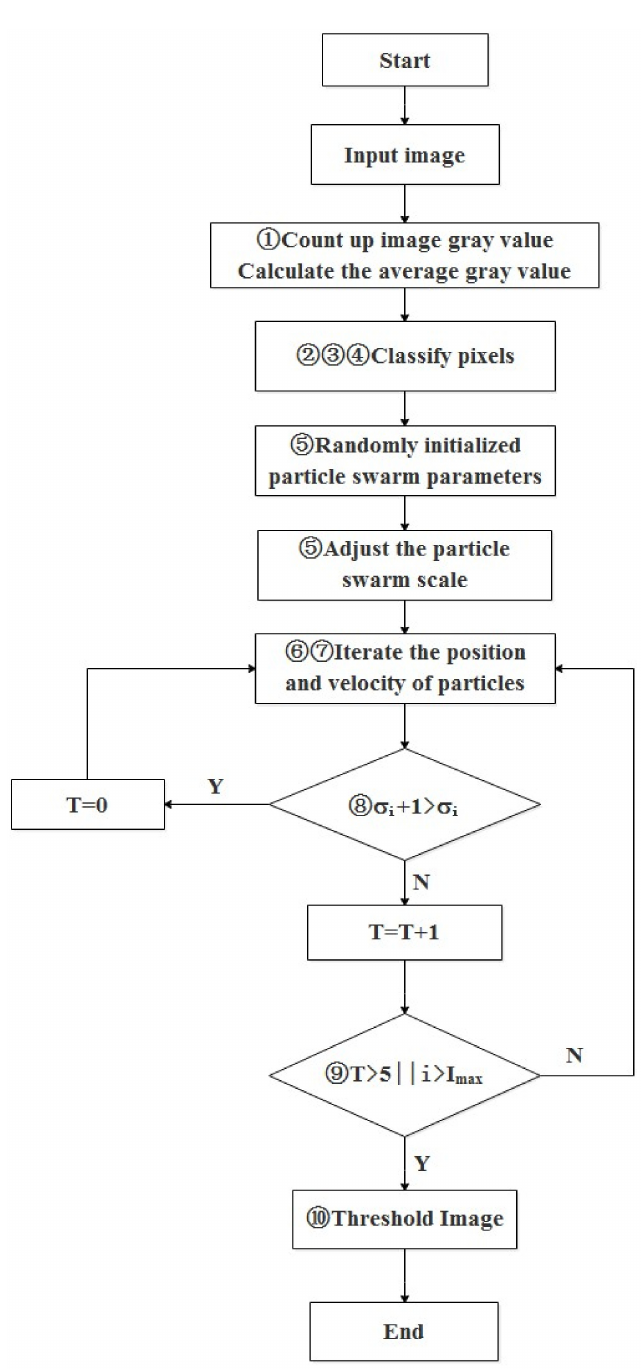
Figure 2. Flow chart of improved particle swarm optimum